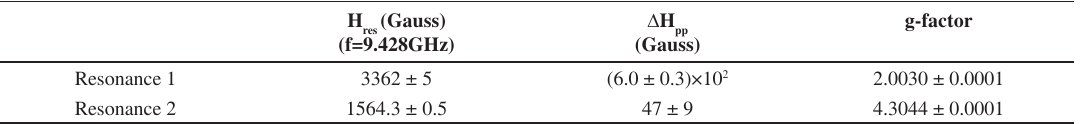
Table 2. FMR parameters obtained from Figure